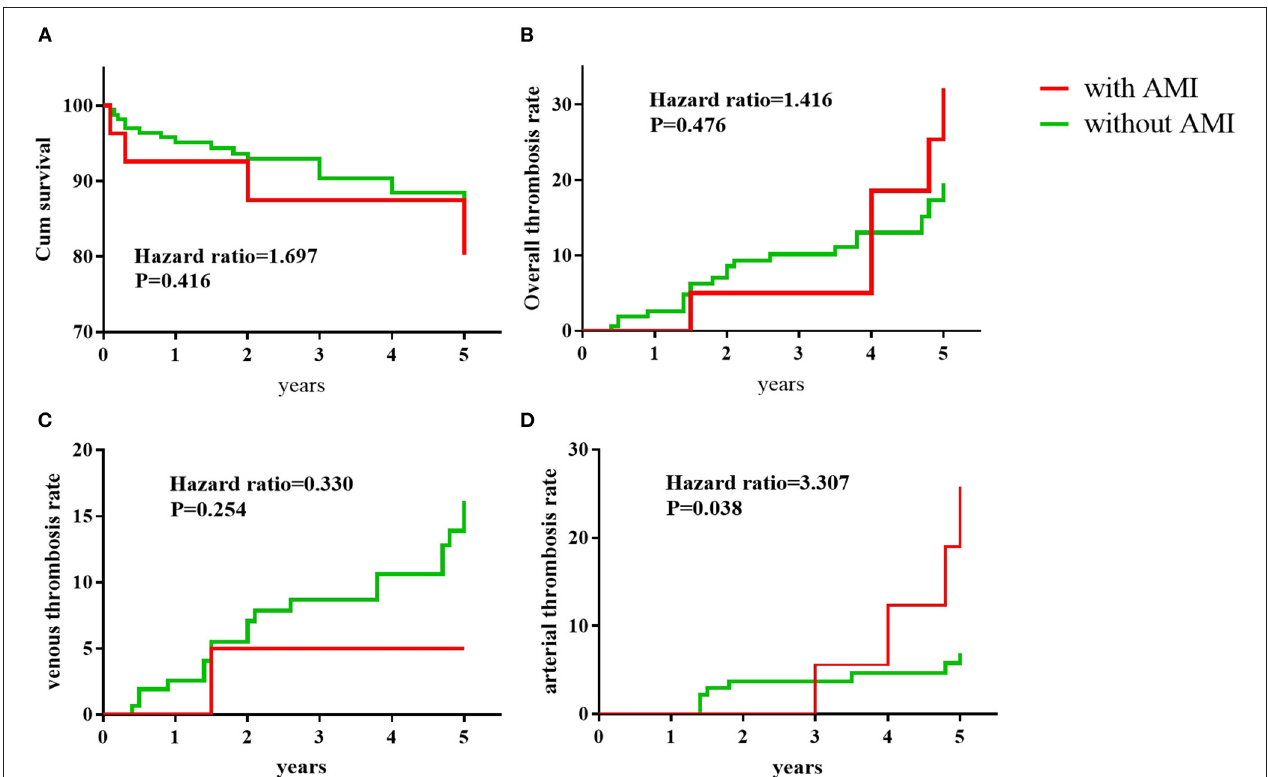
FIGURE 2 | Clinical outcomes during the 5-year follow-up. Kaplan–Meier analysis of the portion of APS patients remaining survival (A) , with overall recurrent thrombosis (B) , recurrent venous thrombosis (C) , and recurrent arterial thrombosis (D) . P- values were calculated with the use of the stratified log-rank test.